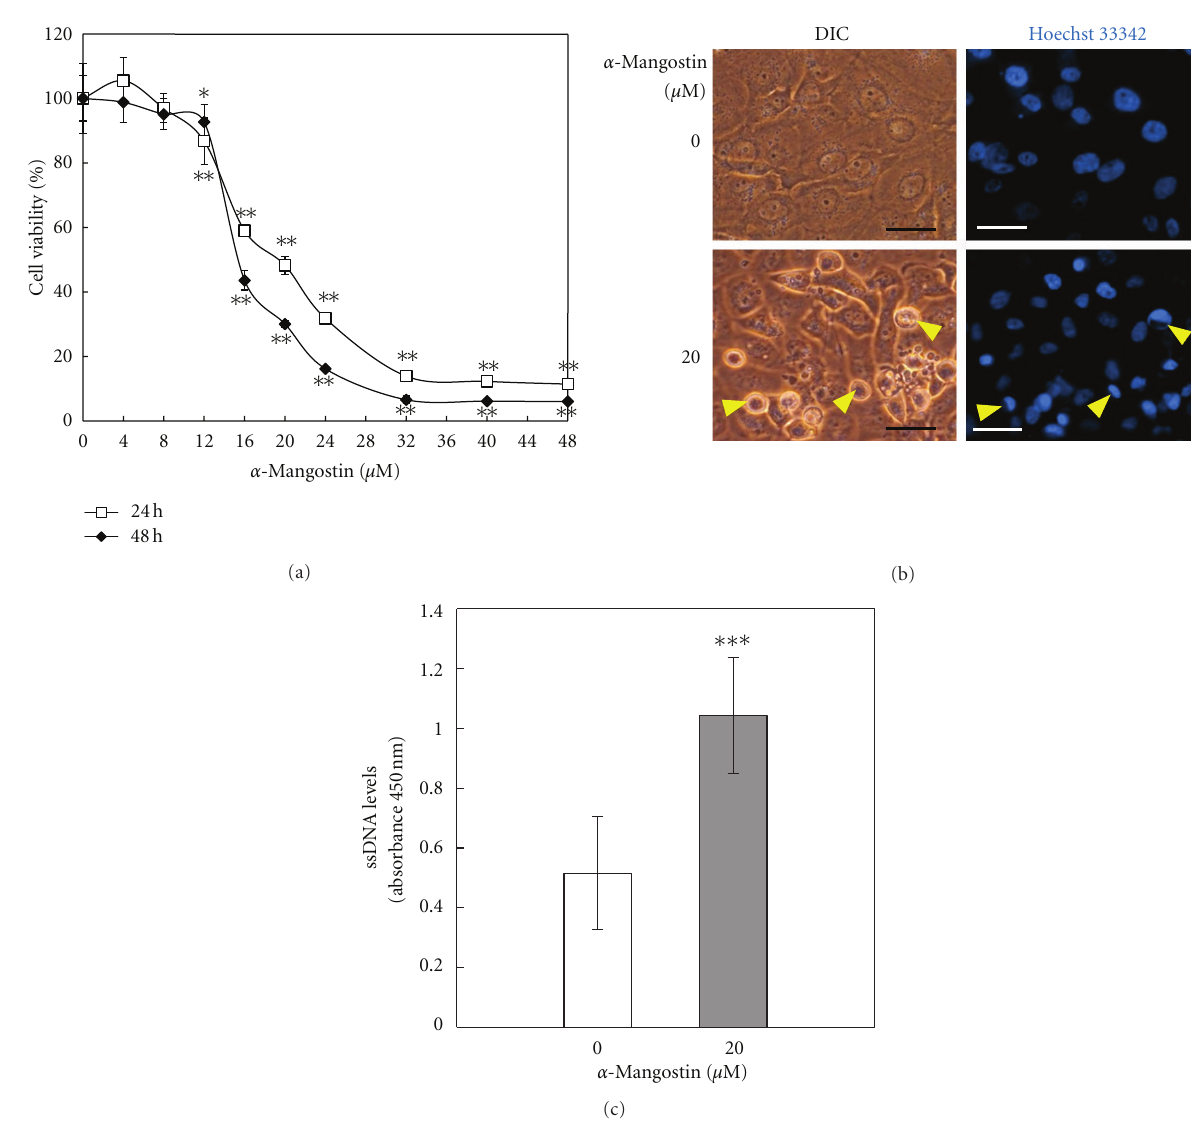
Figure 1: Cell viability and apoptosis detection in MDA-MB231 cells after α -mangostin treatment. (a) Cell viability was significantly lower in human mammary carcinoma MDA-MB231 cells treated with more than 12 μ M α -mangostin for 24 or 48 h ( ∗ P < 0 . 05, ∗∗ P < 0 . 01). Five samples from each of α -mangostin dosage were examined. The IC 50 concentration was determined to be 20 μ M for 24h; therefore, 20 μ M α -mangostin was used for all in vitro studies. (b) Morphological changes in MDA-MB231 cells treated with 20 μ M α -mangostin for 24 h, as compared to controls. Upper two panels show controls and lower two panels show α -mangostin-treated cells. α -Mangostin-treated cells appeared shrunken and chromatin condensation was observed (yellow arrow heads in lower right panel). Scale bars = 50 μ m. (c) ssDNA levels were determined by ELISA and were significantly elevated in cells treated with α -mangostin for 24 h, as compared to control levels ( ∗∗∗ P < 0 . 001). Data are presented as mean ± SD. For all analyses, five samples from control and α -mangostin-treated cells were